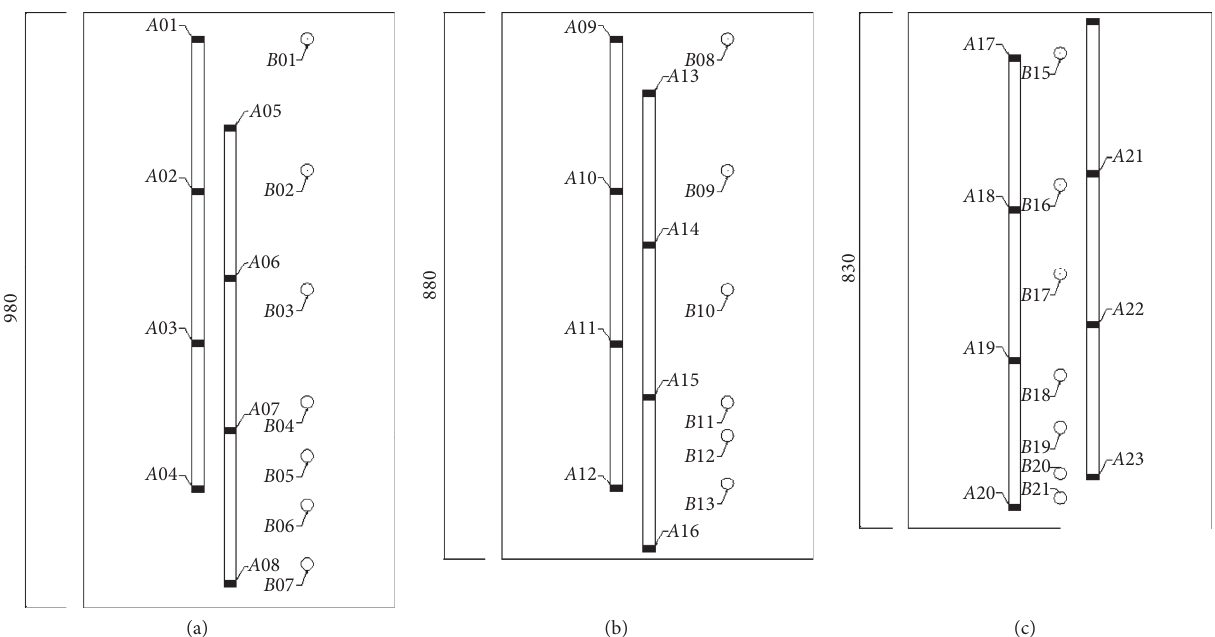
Figure 5: The location of the displacement sensor and Earth pressure cell. (a) The embedded depth of 0.40H. (b) The embedded depth of 0.36H. (c) The embedded depth of 0.30H.